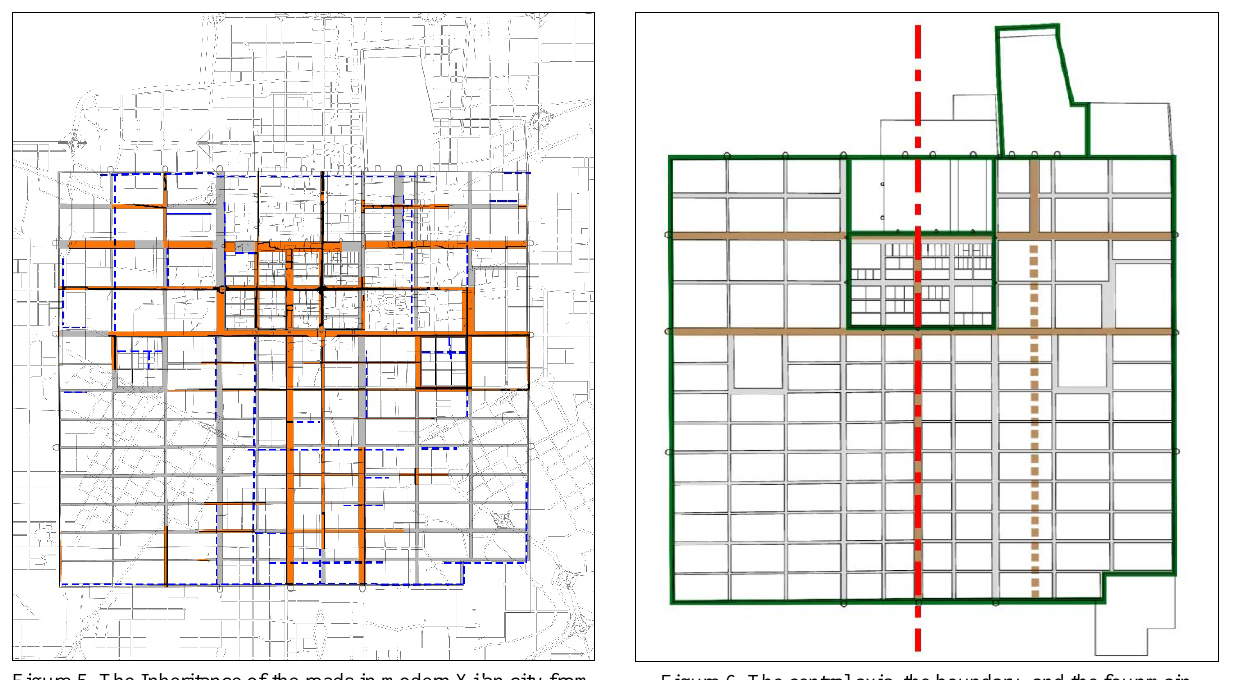
Figure 6. The central axis, the boundary, and the four main streets of Chang'an City of Tang